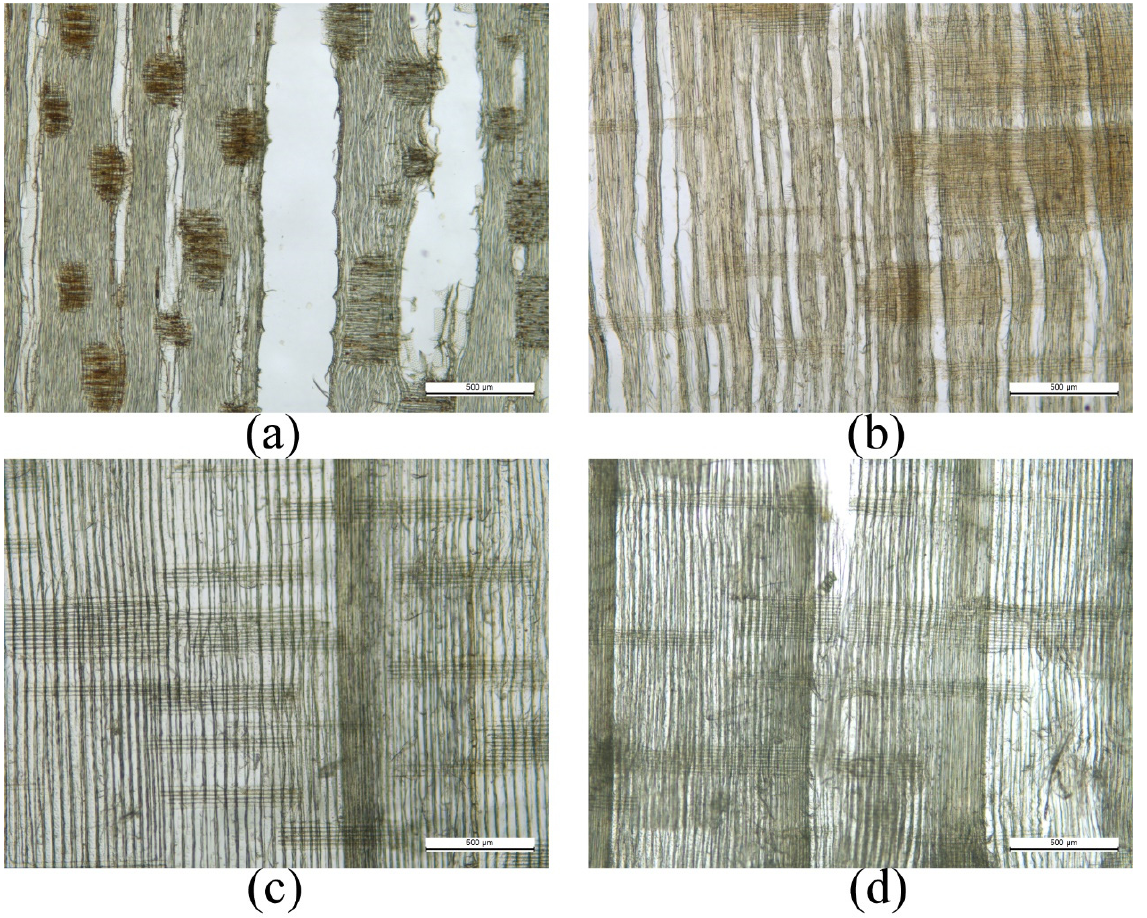
Figure 11. Microstructure of wood. ( a ) T1 specimen; ( b ) T2 specimen; ( c ) T3 specimen; ( d ) T4 specimen.